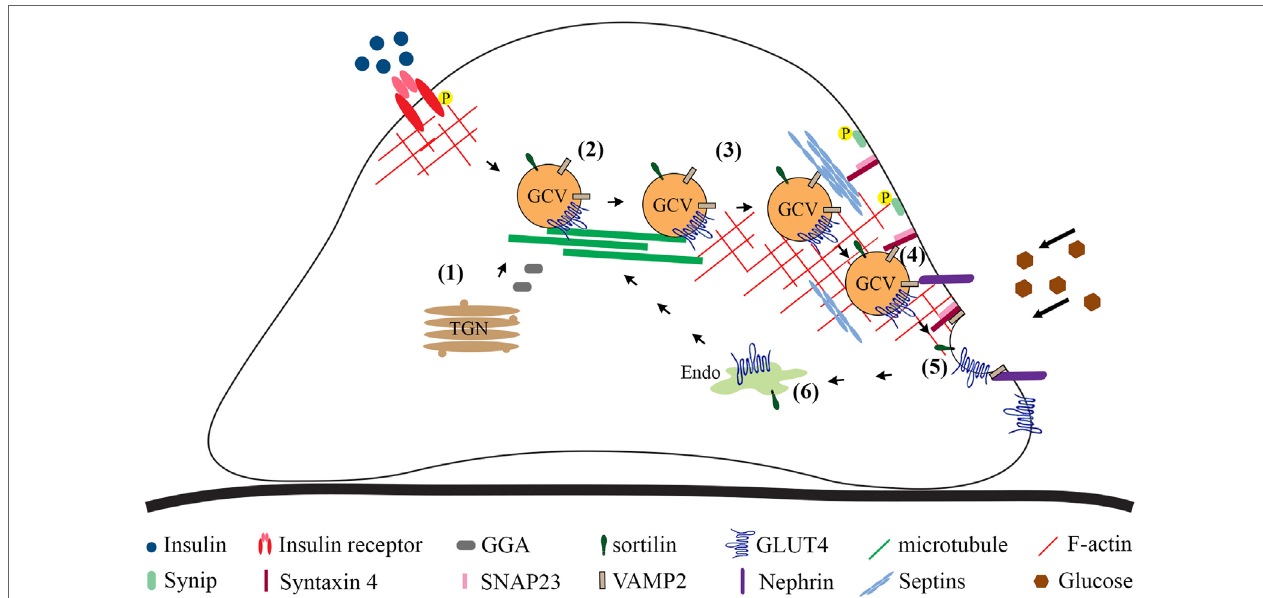
FiGURe 2 | Overview of the steps involved in GLUT4 trafficking to the plasma membrane based on studies carried out in cultured podocytes. Newly synthesized GLUT4 molecules are sorted directly into GCVs (1). GLUT4 may be sorted into GCVs also from other vesicular compartments. Cytoskeleton plays a role in approaching of the vesicles from the perinuclear region to the plasma membrane (2). Tethering (3), docking (4), and fusion (5) are required to merge the lipid bilayer of the GCV with the plasma membrane. Once at the plasma membrane, the GCV docking (4) and fusion (5) require formation of the ternary complex between v-SNARE, VAMP2, on the GCV and t-SNAREs, syntaxin-4 and SNAP23, on the plasma membrane, allowing the extracellular exposure of the GLUT4. (6) GLUT4 present at the plasma membrane is endocytosed and transported to the endosomal system for recycling. GCV, GLUT4-containing vesicle; P, phosphorylation; Endo, endosomes and recycling endosomes; TGN, trans-Golgi network; SNAP23, synaptosome-associated protein, 23 kDa; SNARE, N -ethylmaleimide-sensitive factor attachment protein receptor; t-SNARE, target SNARE; v-SNARE, vesicle SNARE; VAMP2, vesicle-associated membrane protein